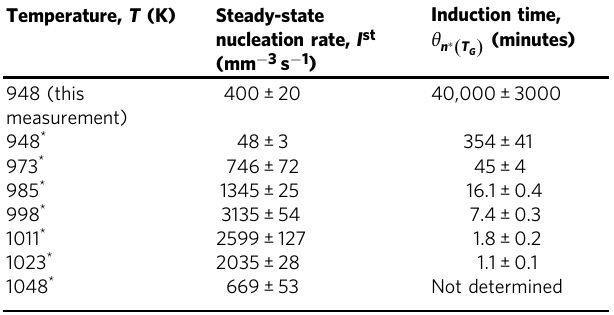
Table 1 Steady-state rates and induction times for nucleation in 5BaO ∙ 8SiO 2 glasses.